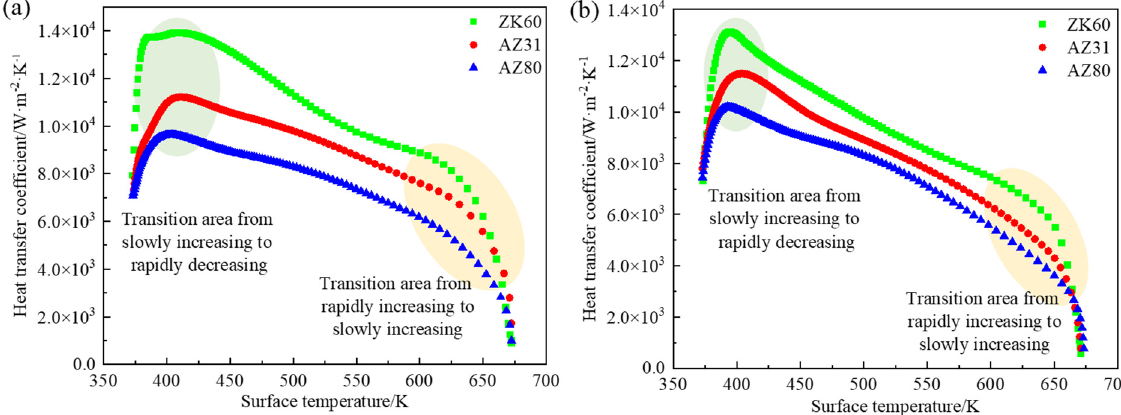
Figure 5. The relationship between HTC and surface temperature of ingot under different alloy types in the impingement zone ( a ) and the free − falling zone ( b ).